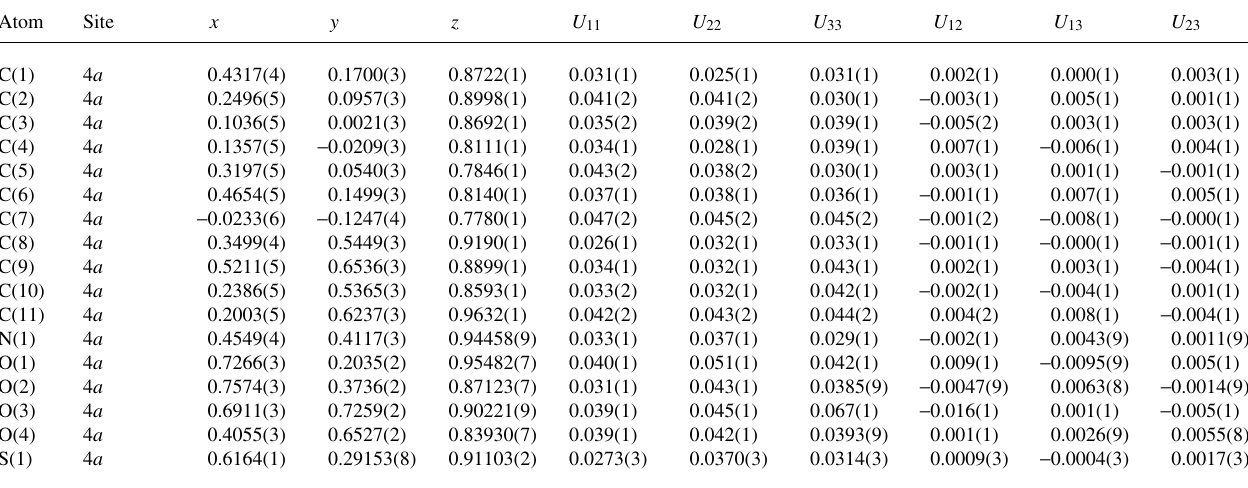
Table 3. Atomic coordinates and displacement parameters (in Å 2 )